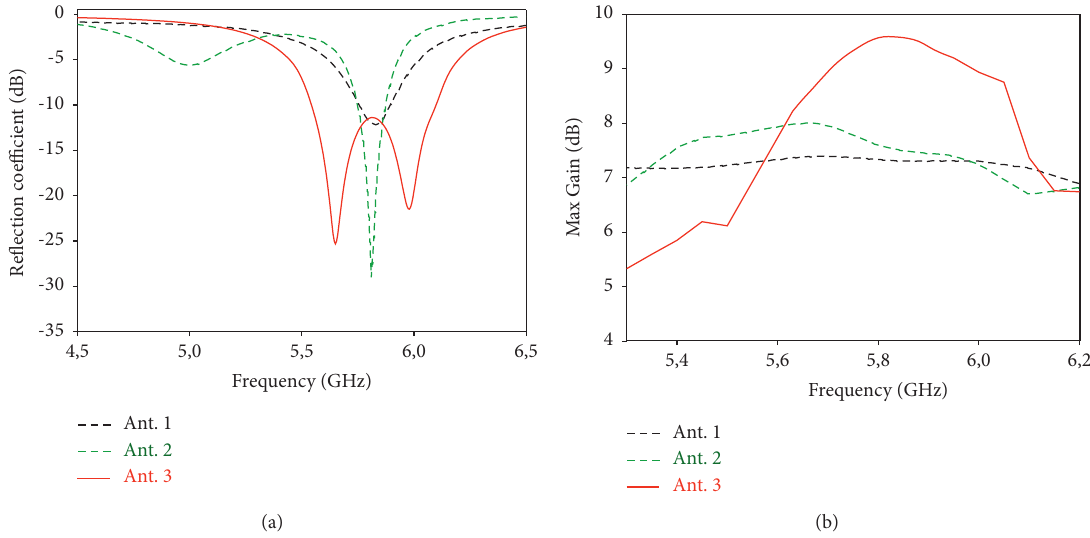
Figure 2: Reflection coefficient (a) and gain (b) for different antennas.